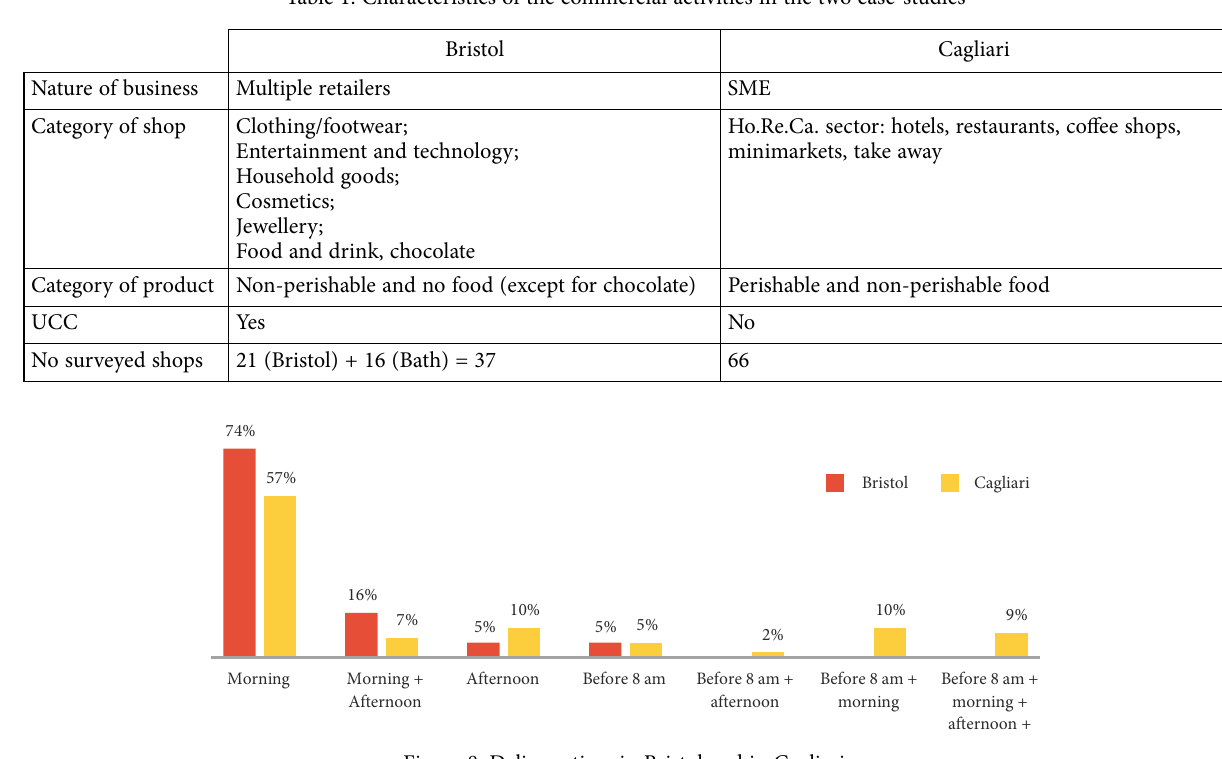
Figure 8. Delivery time in Bristol and in